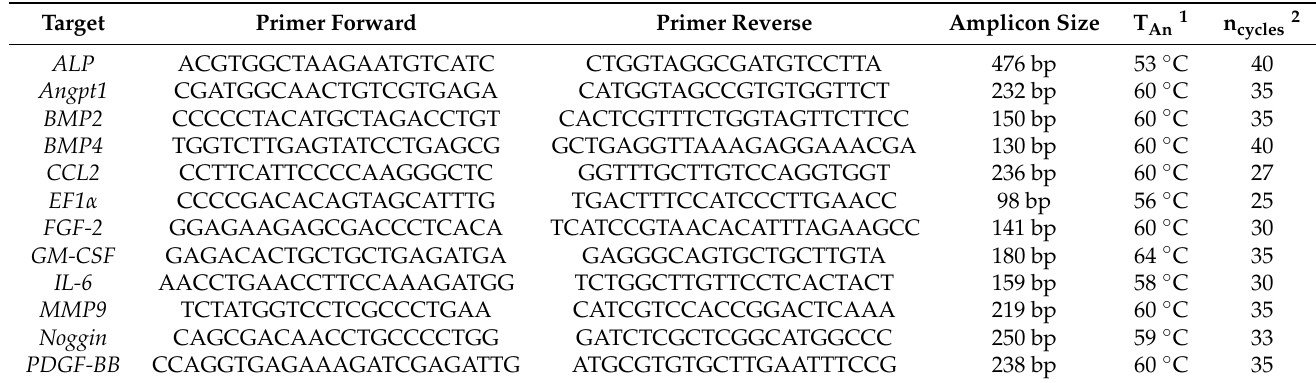
Table 2. Primer details and cycling